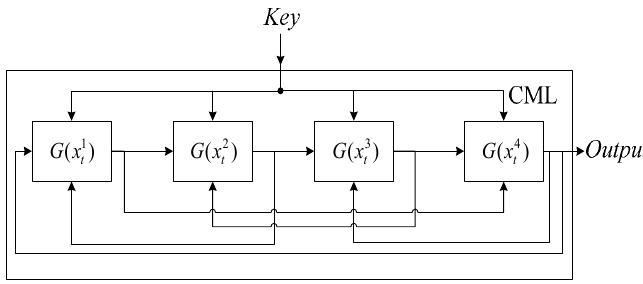
Figure 12. The structure of the improved compound four stage CML, combining both the logistic map and tent map.